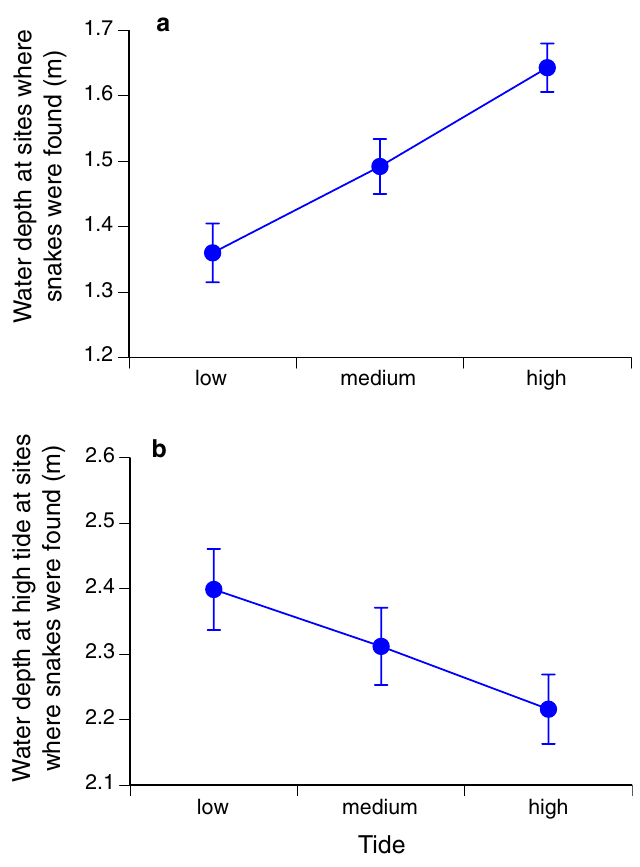
Figure 1. Effect of tidal phase on ( a ) water depth at time of capture in sites where we found sea snakes ( Emydocephalus annulatus ), and on ( b ) the depth of water at high tide at those same sites. Graphs show mean values (± 1